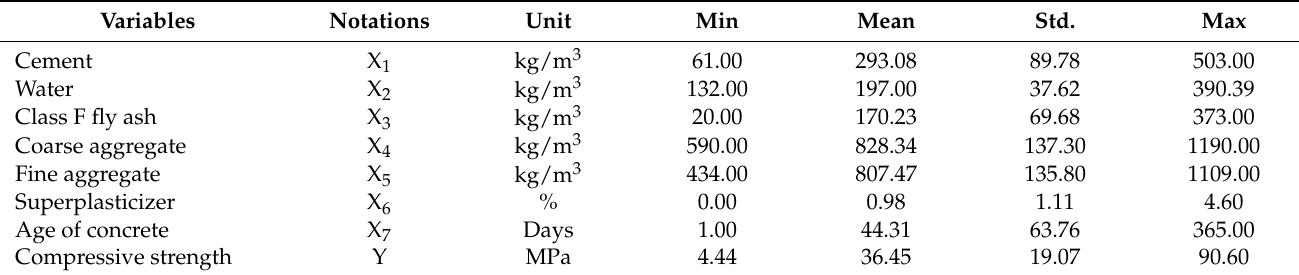
Table 5. The variables used in the Dataset 4.